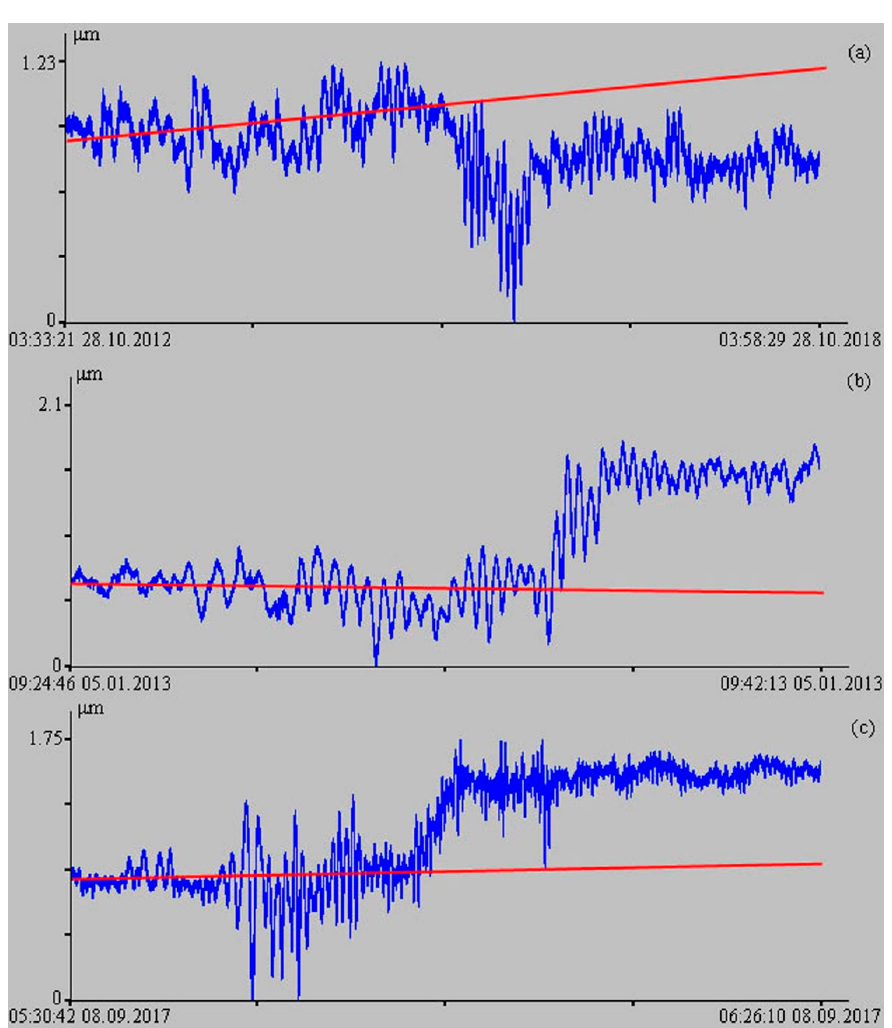
Figure 9. Fragments of 52.5 m laser strainmeter recordings from October 2012 ( a ), January 2013 ( b ), and September 2017 ( c ).